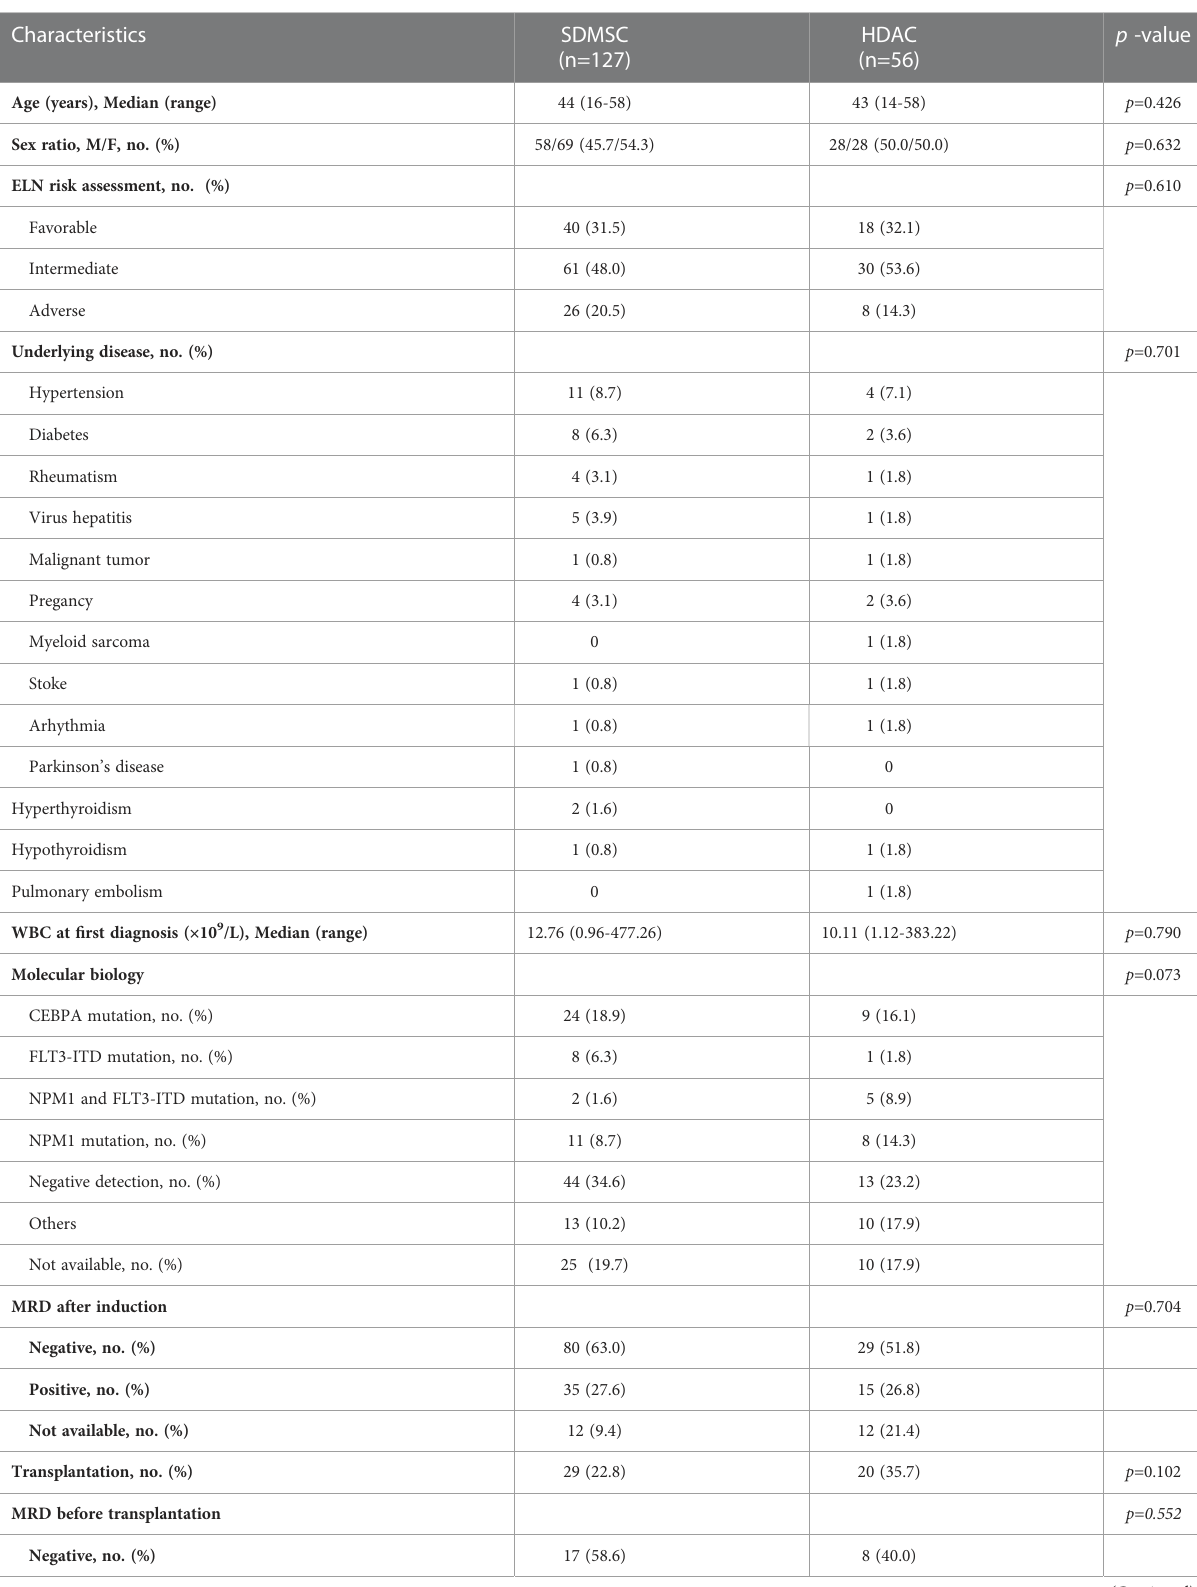
TABLE 1 Baseline clinical characteristics of